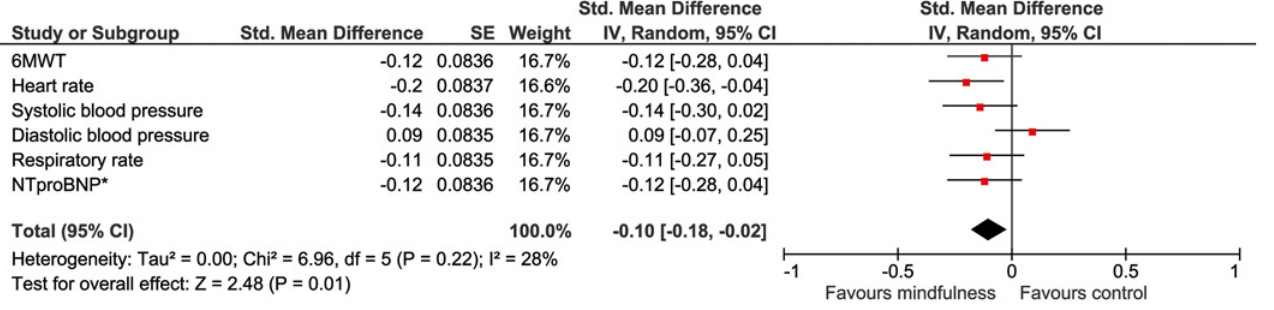
Fig 4. Forest plot showing the Intention-to-Treat Cohen ’ s D results of the effectiveness of the mindfulness intervention compared with usual care on the physiological outcomes. The width of the line indicates the 95%CI. All values lower than 0 indicate a significant difference in favour of the mindfulness group.